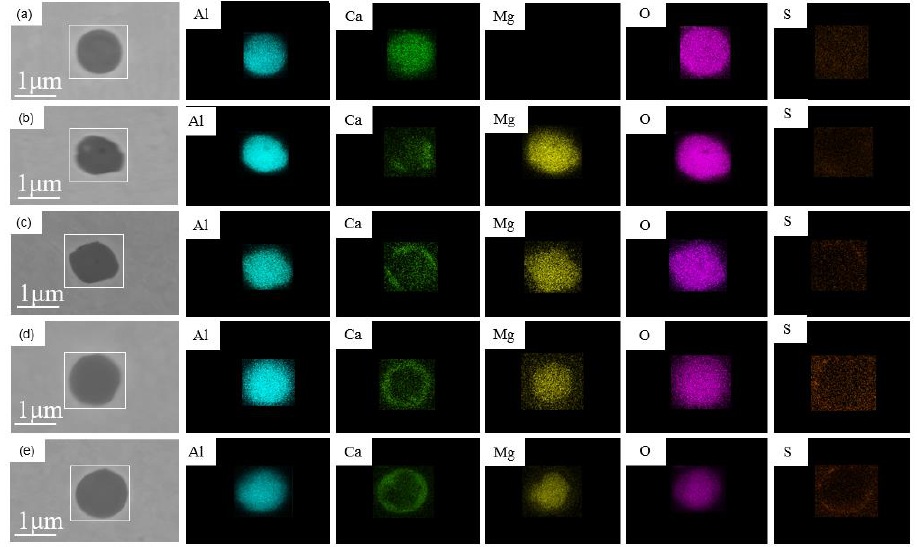
Figure 4. Typical inclusions when adding Mg after Ca ( a ) 30 s after Ca addition, ( b ) 30 s after Mg addition, ( c ) 5 min after Mg addition, ( d ) 15 min after Mg addition, ( e ) 30 min after Mg addition.